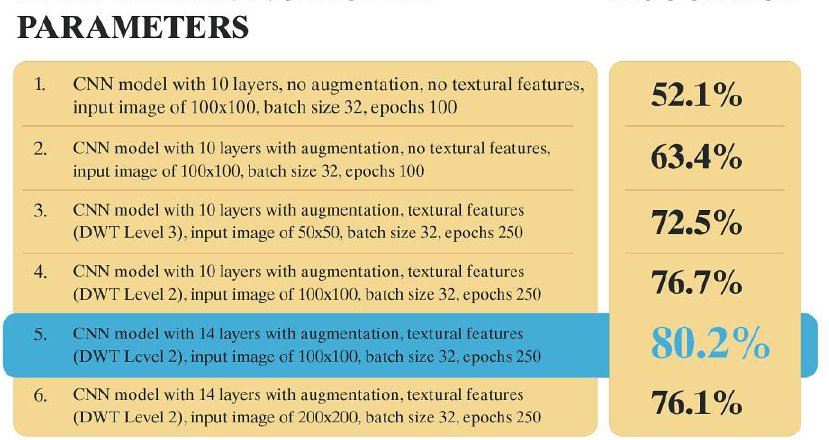
Figure 4. Comparison of deep learning configurations with different parameter combinations, with and without augmentation. Configuration 5 achieved the highest accuracy.